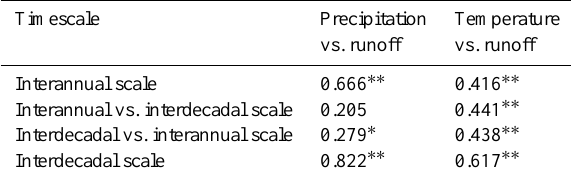
Table 1. Correlations between runoff and climate factors.